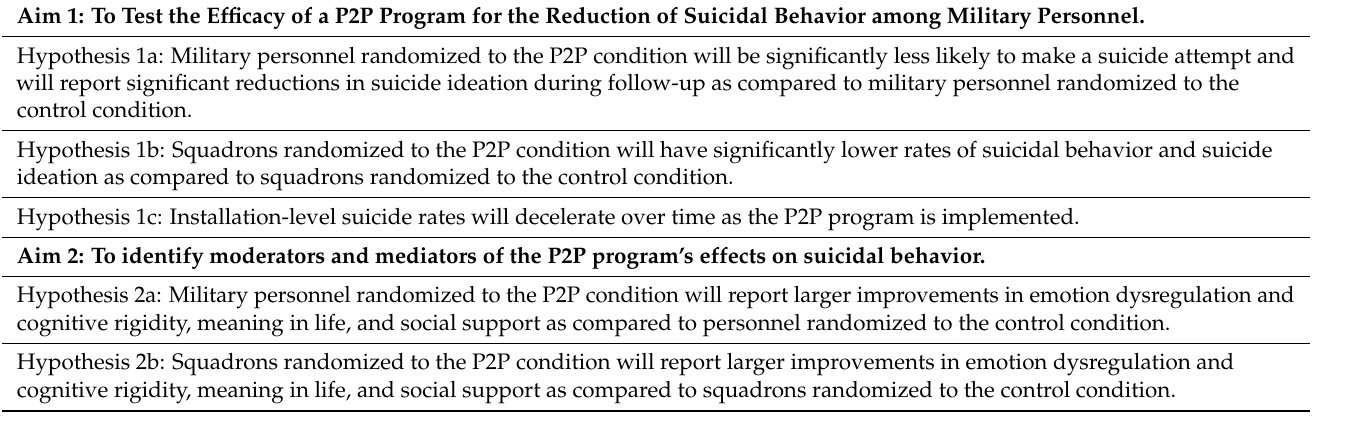
Table 3. Primary and secondary aims and hypotheses for Airman’s Edge P2P